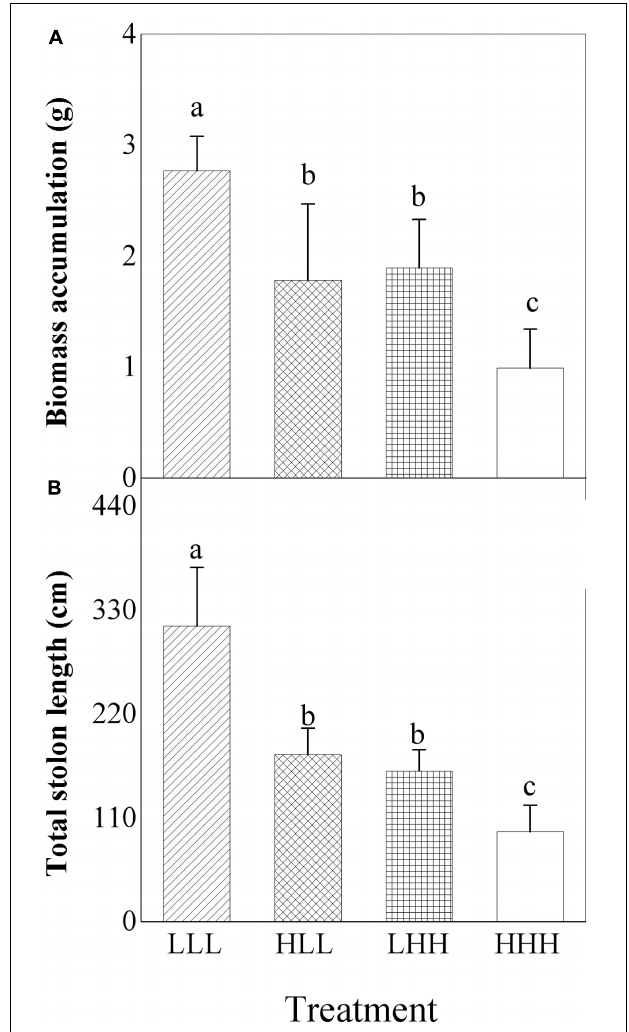
FIGURE 5 | Effects of transgenerational plasticity on growth performance of offspring ramets (F 2 generation). The same lower case letters are not significantly different at the P = 0.05 level. Values are means ± s.e. (standard errors), n = 8. HHH: F 0 generation high light + F 1 generation high light + F 2 generation high light; HLL: F 0 generation high light + F 1 generation low light + F 2 generation low light; LHH: F 0 generation low light + F 1 generation high light + F 2 generation high light; LLL: F 0 generation low light + F 1 generation low light + F 2 generation low